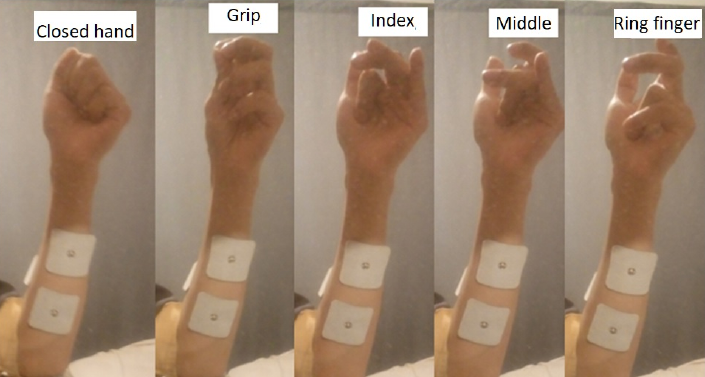
Figure 13. Positions of the hand and fingers that are characterized.